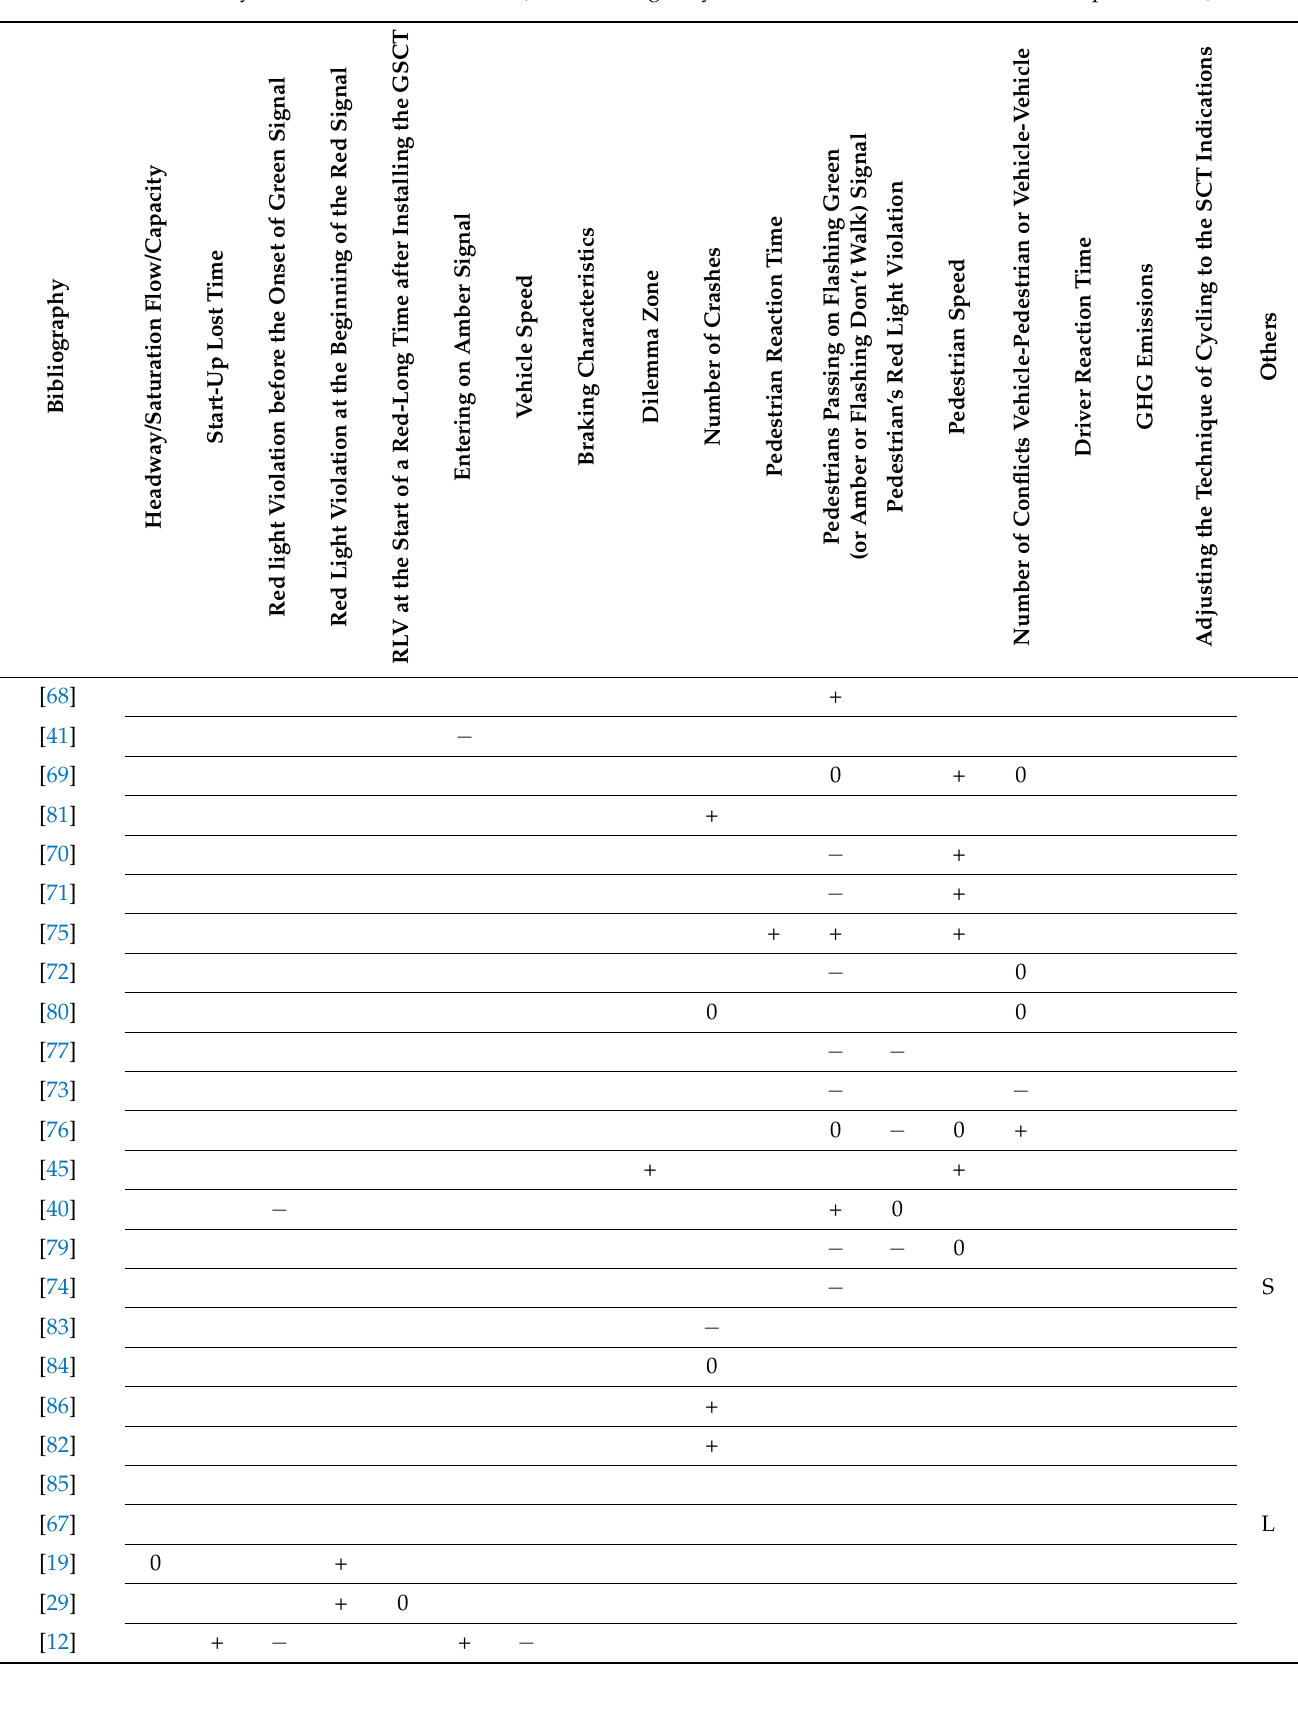
Table 1. Summary of research results on SCT (set chronologically and divided into SCT for drivers and